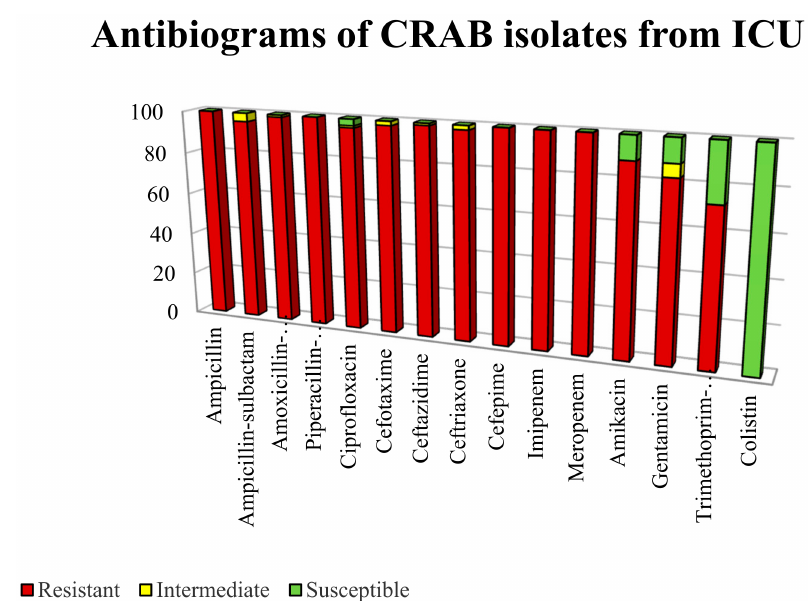
Figure 1. The antibiotic susceptibility profile of the CRAB isolated from intensive care